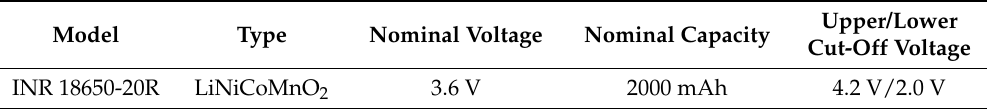
Table 1. Key specification of Li-ion battery.